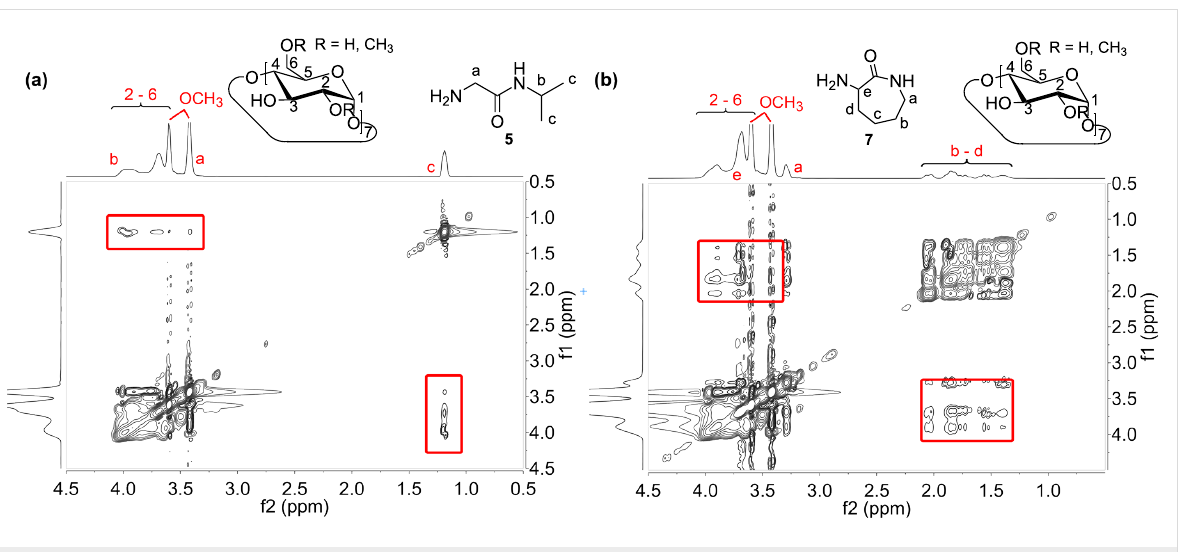
measurements. A mixture of 5 and 8 showed a low